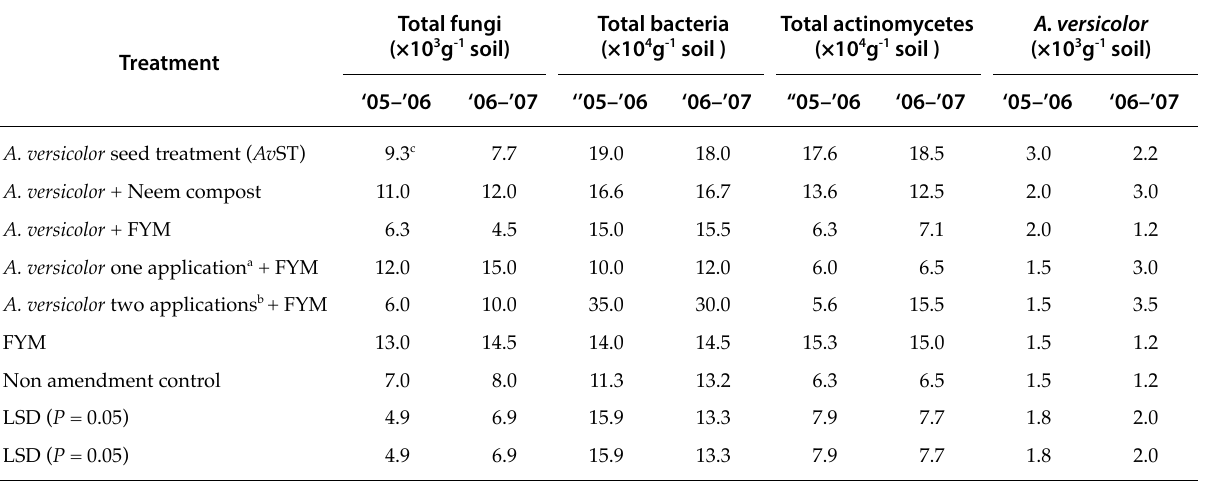
Table 6. Mean soil populations of soil microorganisms and Aspergillus versicolor in cumin field plot soils in two growing seasons, after different methods of A. versicolor application.